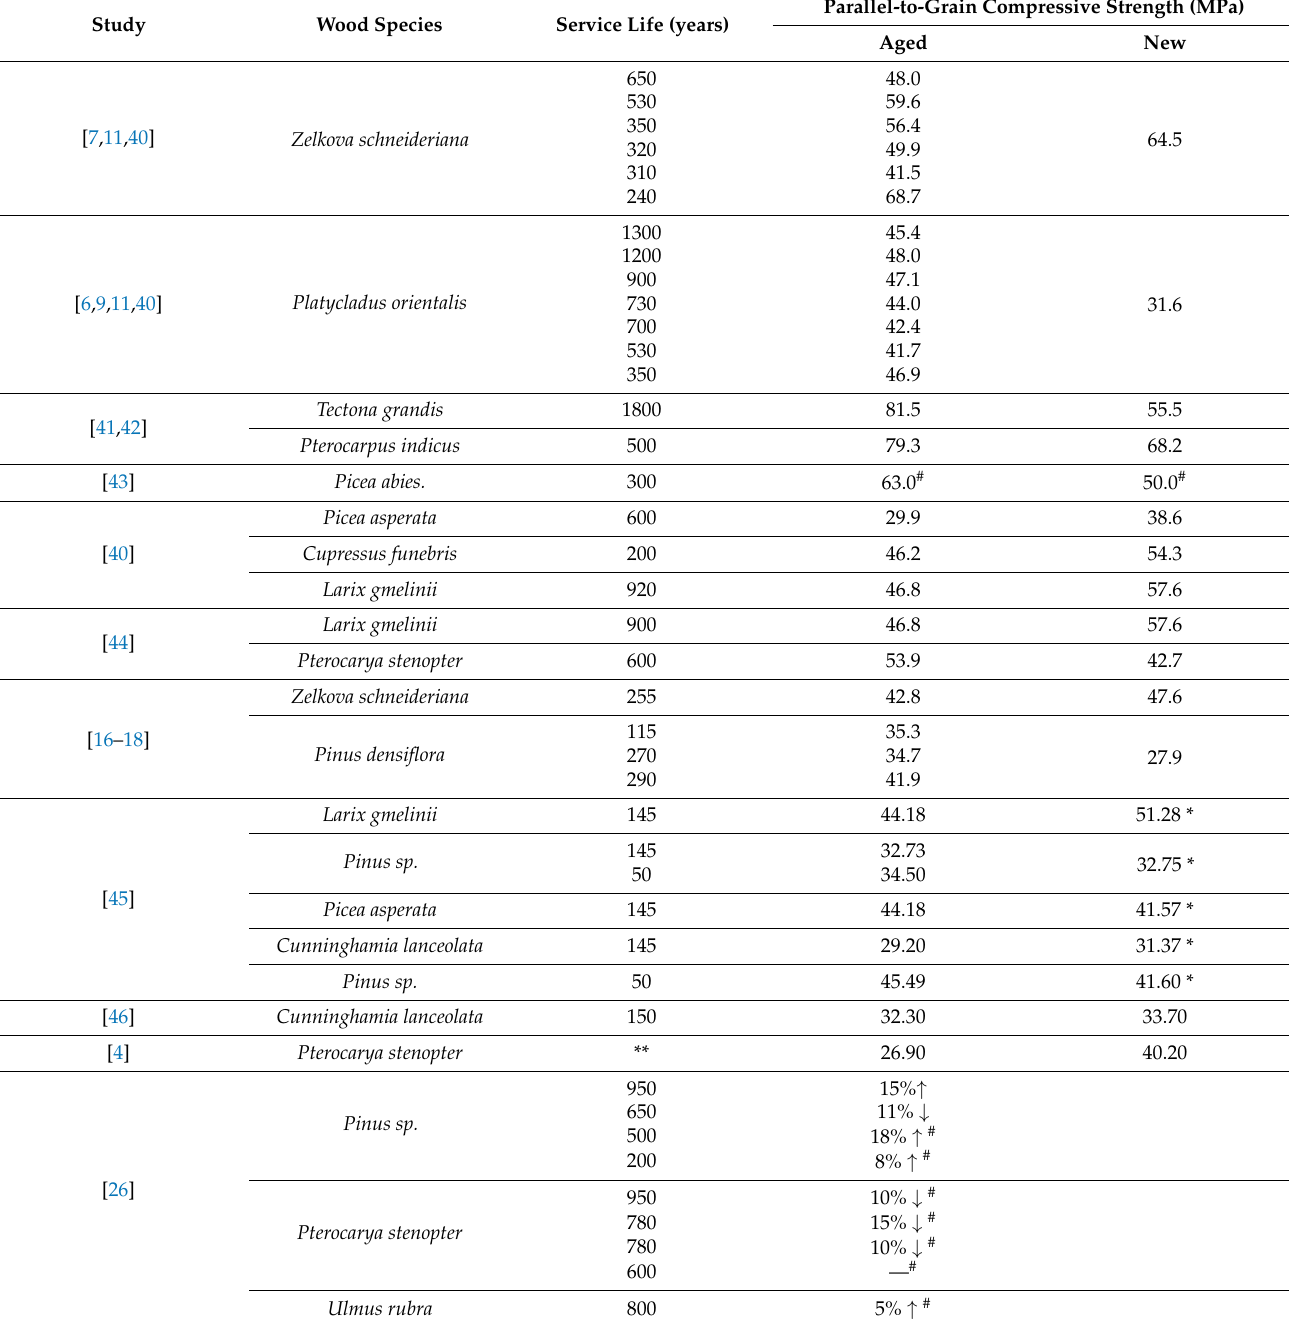
Table A1. Summary of published test results on the parallel-to-grain compressive strength of aged